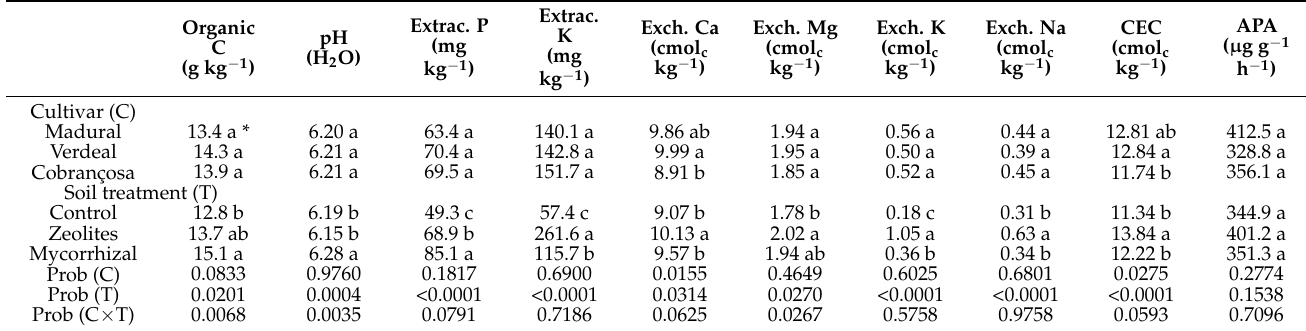
Table 5. Organic carbon (C), pH (H2O) , extractable phosphorus (P) and potassium (K), exchangeable calcium (Ca), magnesium (Mg), K and sodium (Na), cation exchange capacity (CEC), and acid phosphatase activity (APA) in the growing medium at the end of the experiment in the factorial design cultivars × soil treatments.